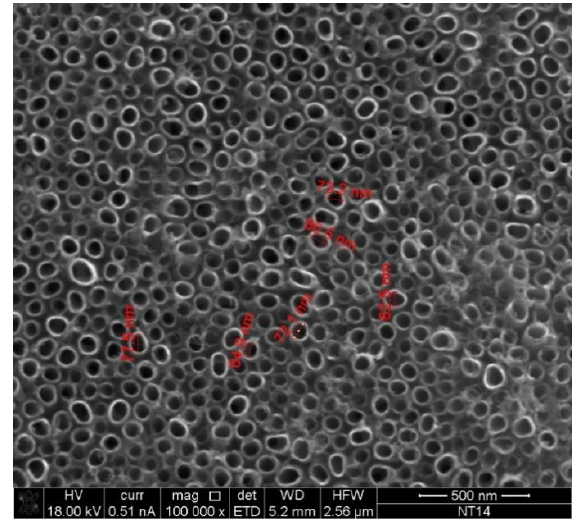
Figure 12. SEM image of the nanotubular structure used as anode in the photo electrochemical cell. A mean tube diameter of 70 nm was calculated for this sample.